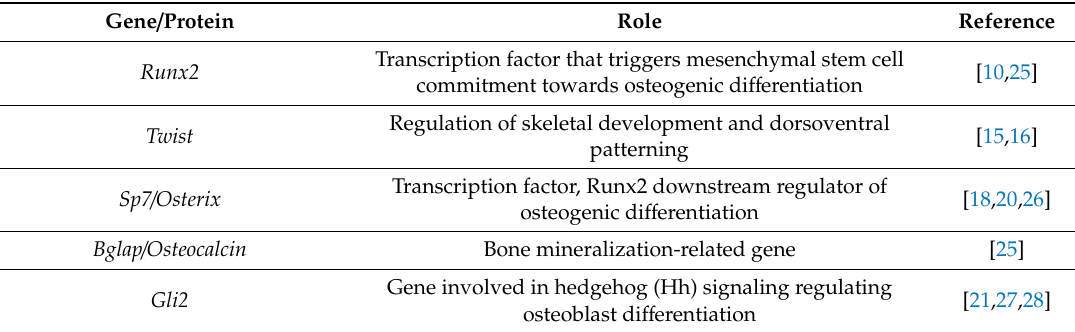
Table 1. Genes involved in bone formation in